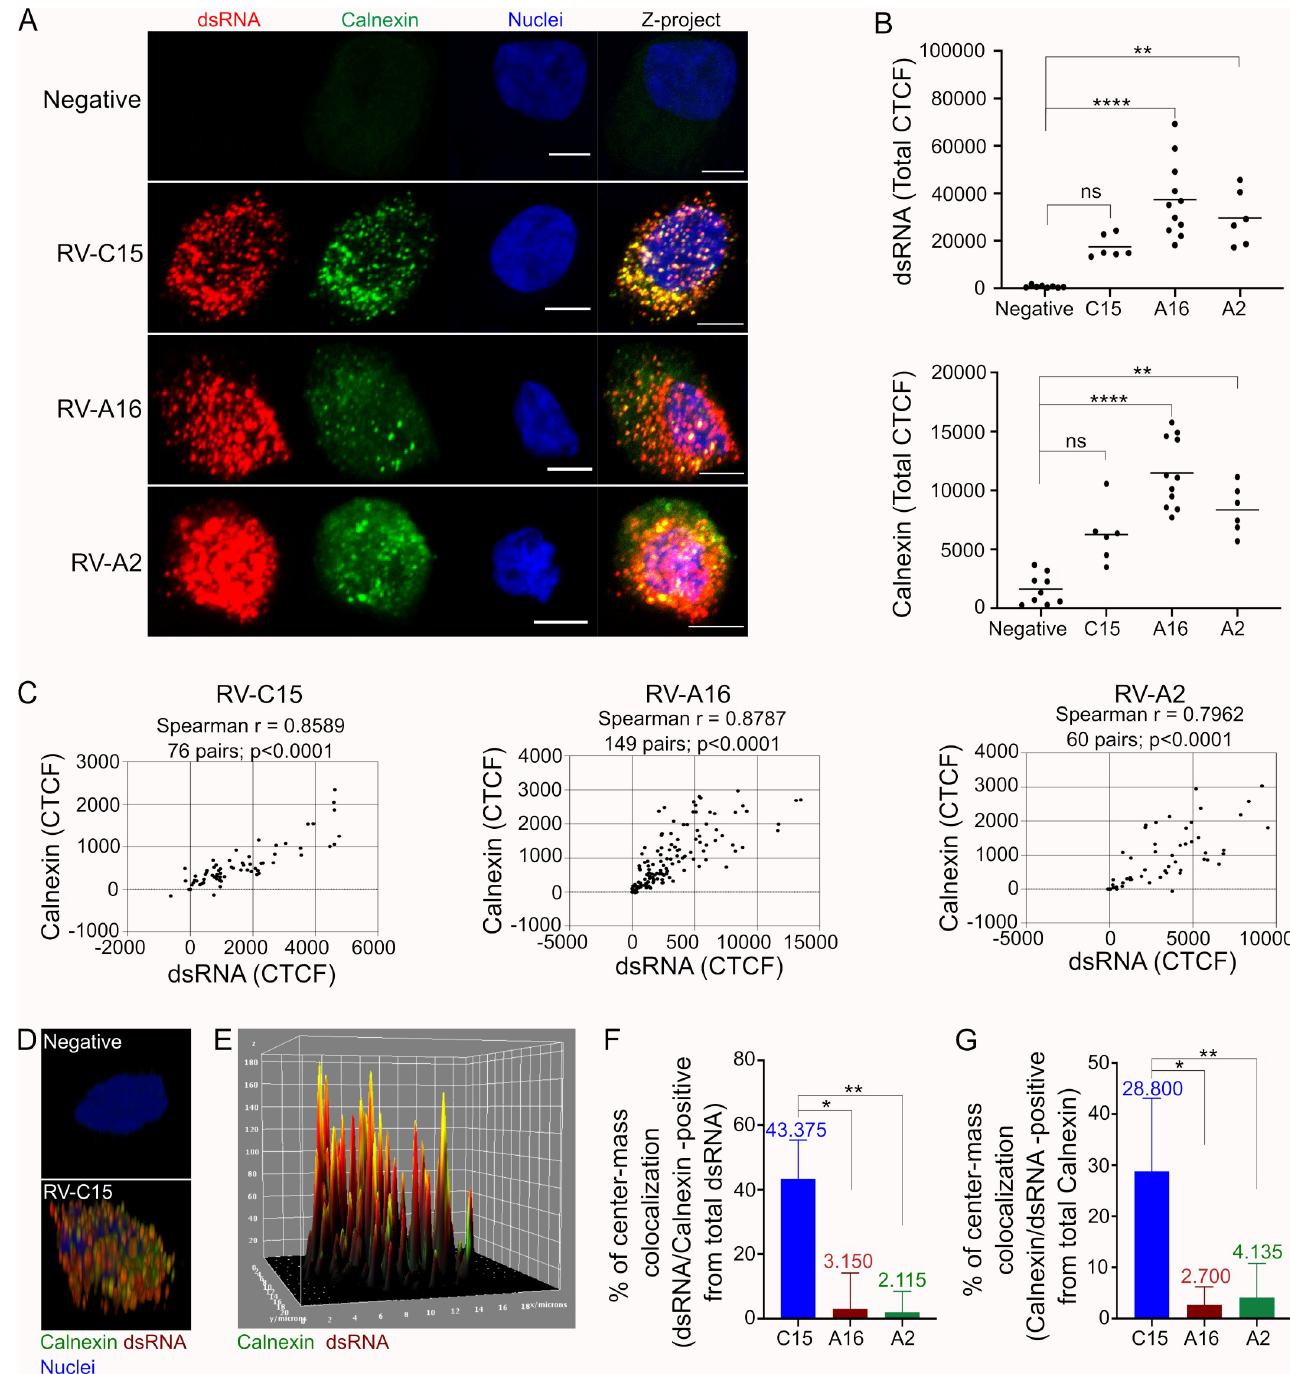
Fig 4. ER is a site for RV-C15 genome replication in HAE. A : Detection of calnexin (ER marker, green; nuclei, blue) in non-infected or rhinovirus-infected (dsRNA+, red) HAE at 12hpi (z-stacks at 1 μ m of thickness; scale bar = 5 μ m). B: Quantification of fluorescence levels (CTCF; line = mean) of dsRNA and calnexin in non-infected cells and RV-infected (dsRNA+) HAE detected by immunofluorescence at 12hpi. Dots represent the total CTCF per cell. Statistical analysis was done using Kruskal-Wallis test following Dunn’s multi-comparison test ( �� p < 0.01, ���� p < 0.0001). C: Spearman correlation analysis (two-tailed; 0.95% confidence interval) between calnexin and dsRNA fluorescence levels (CTCF) in RV-C15, -A16, or -A2-infected HAE at 12hpi. Each dot represents the fluorescence levels of dsRNA and calnexin quantified in the same Z-slice. D: 3D view of RV-C15-infected HAE shows the immunodetection of calnexin (green), viral dsRNA (red), and calnexin/dsRNA colocalization (yellow) at 12hpi (z-stacks at 1 μ m of thickness). E: 3D surface plot of RV-C15-infected HAE shows the detection of calnexin (green), dsRNA (red), and calnexin/dsRNA colocalization (yellow) by immunofluorescence at 12hpi. F-G: Spatial colocalization analysis